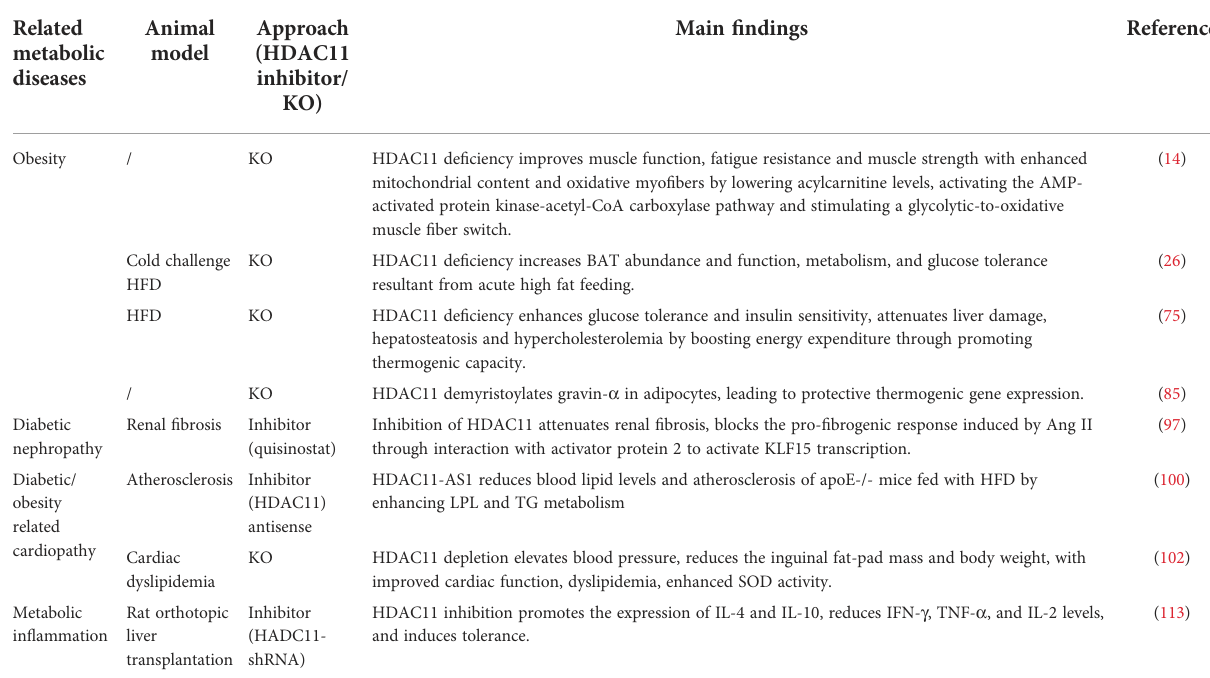
Diabetic nephropathy Diabetic/